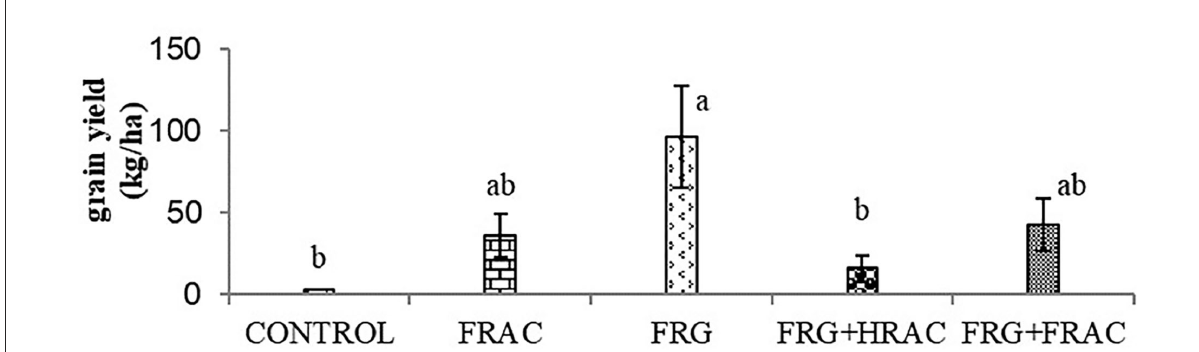
FIGURE4 Mean grain yield (kg/ha) affected by fertilizer treatments across 16, 40, and 80 % field capacities moisture. Control is no amendment; FRAC is full-rate compost; FRG is full-rate glycine mix fertilizer; HRAC is half-rate compost. Error bars represent standard errors of the fertilizer treatment means. Different lowercase letters on top of the bars represent significant differences at least significant difference of 5% probability. Adapted from Brempong et al.